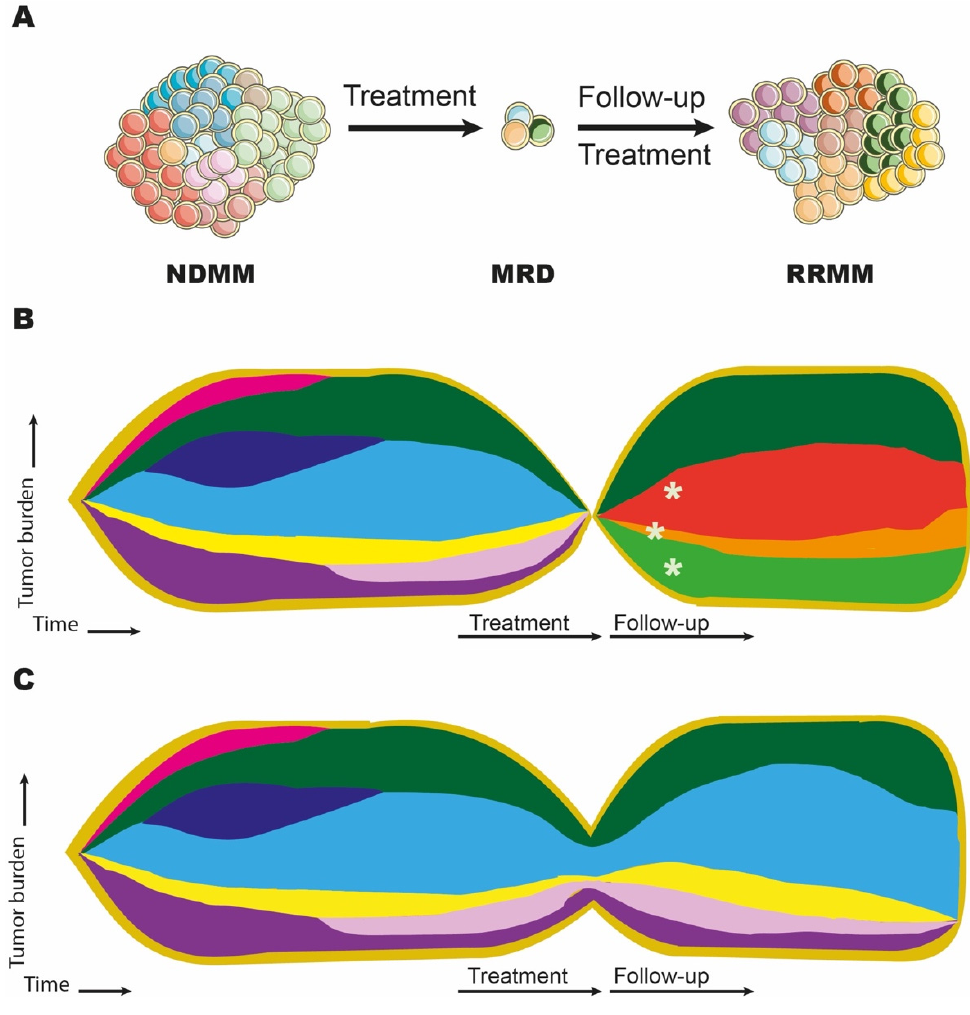
Figure 3. Clonal evolution of multiple myeloma during therapy. Each color represents a single subclone. ( A ) Treatment-resistant subclones evolve at the MRD stage, being the source for overt disease relapse; ( B ) Selection of preexisting subclones and formation of new subclones (marked with stars) during antimyeloma therapy. ( C ) Change in the subclonal architecture of multiple myeloma during therapy with the selection of some subclones (green, light blue, yellow, purple, lavender) and the disappearance of others (pink, dark blue). Abbreviations: MRD, measurable residual disease; NDMM, newly diagnosed multiple myeloma; RRMM, relapsed/refractory multiple myeloma. The figure was prepared using images provided by Servier Medical Art (https://smart.servier.com accessed on 23 August